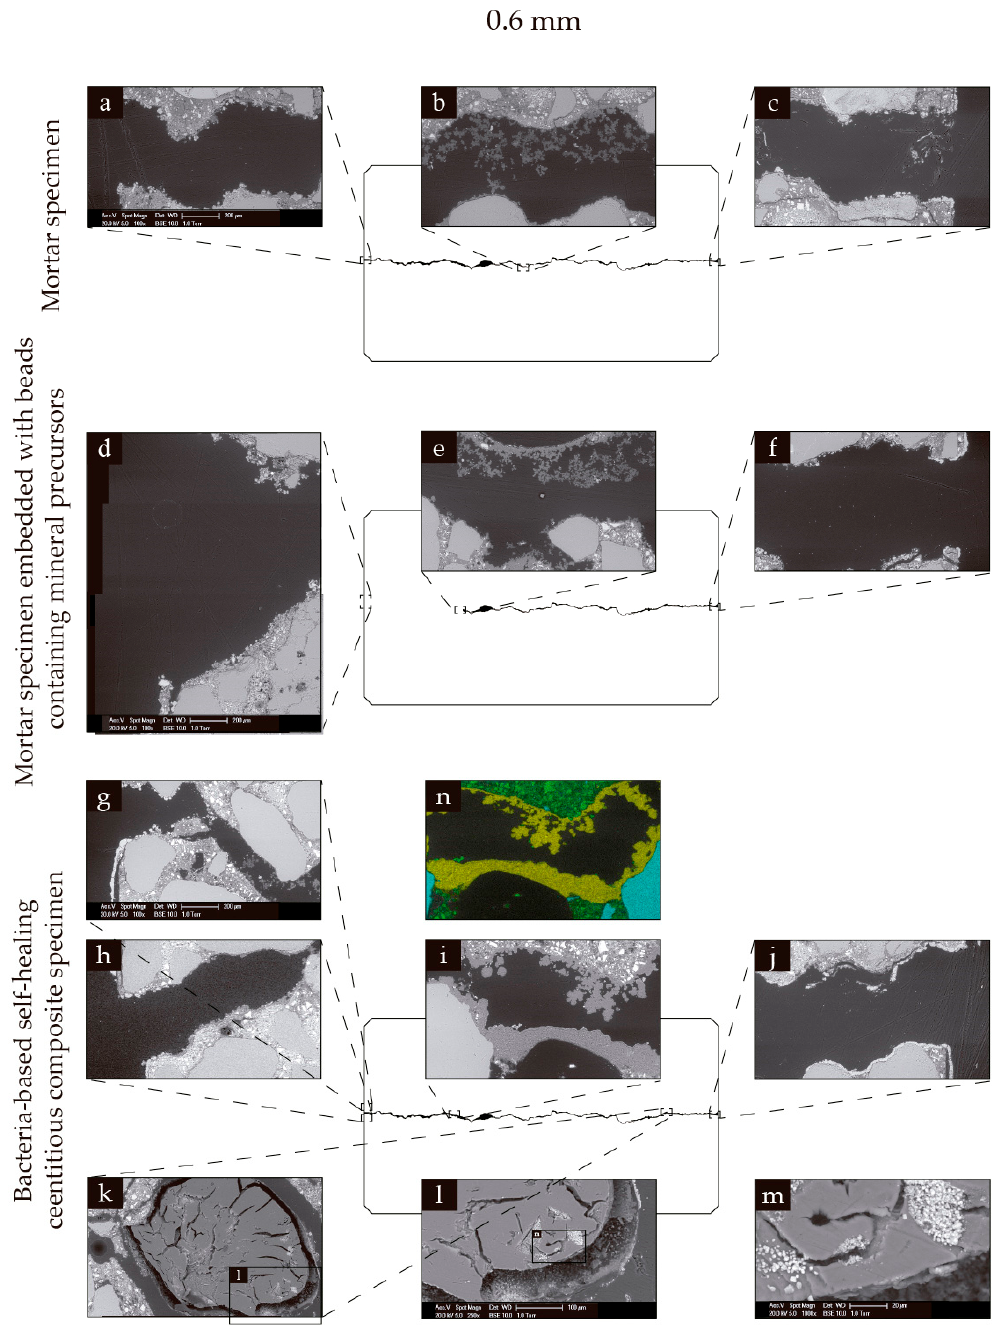
Figure 7. Environmental scanning electron microscopy (ESEM) and energy dispersive spectroscopy (EDS) images of specimens with 0.6 mm wide cracks. ( a – c ) ESEM images of a mortar specimen following 56 days of submersion in seawater at 8 °C: ( a ) a crack mouth; ( b ) an area towards the center of the crack; and ( c ) the other crack mouth. ( d – f ) ESEM images of a mortar specimen incorporated with beads containing mineral precursor compounds after 56 days of submersion in seawater at 8 °C: ( d ) a crack mouth; ( e ) an area towards the centre of the crack; and ( f ) the other crack mouth. ( g – m ) ESEM images of a bacteria ‐ based self ‐ healing cementitious composite specimen following 56 days of submersion in seawater at 8 °C: ( g , h ) a crack mouth, which had split into two smaller cracks; ( i ) an area towards the centre of the crack; ( j ) the other crack mouth; ( k ) a section along the crack including a bacteria ‐ based bead; and successive close ‐ ups ( l , m ) of a bacteria ‐ based bead. The EDS elemental map ( n ) corresponding to ESEM image ( i ). Green of the EDS maps represents calcium, yellow represents magnesium and blue represents silicate.